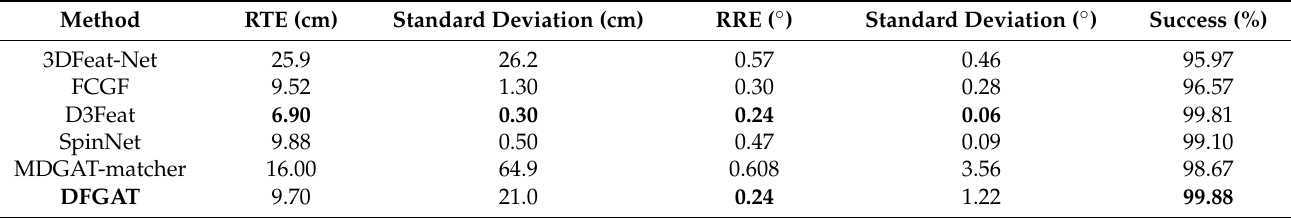
Table 3. Registration results on